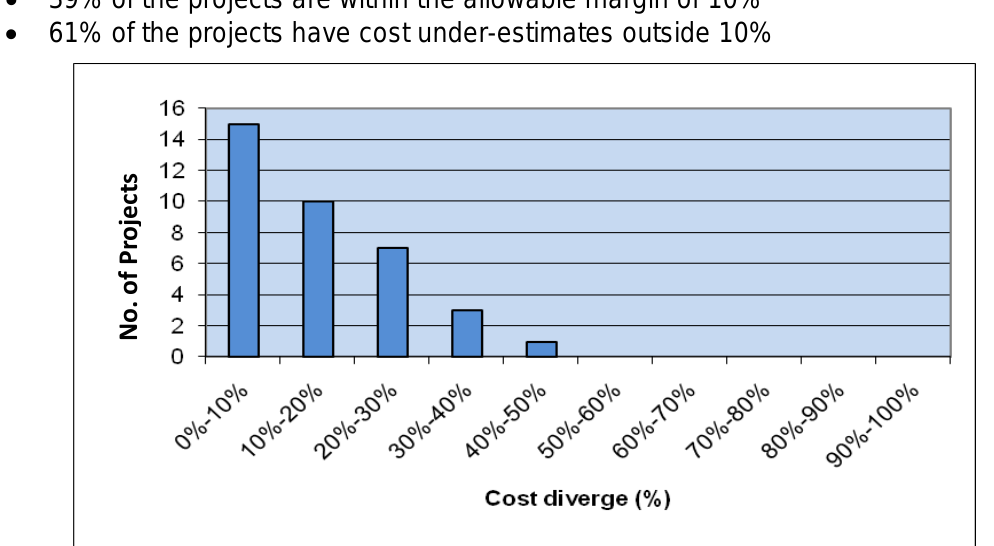
Figure 9 Cost under-estimates vs. no of projects in large sized road construction